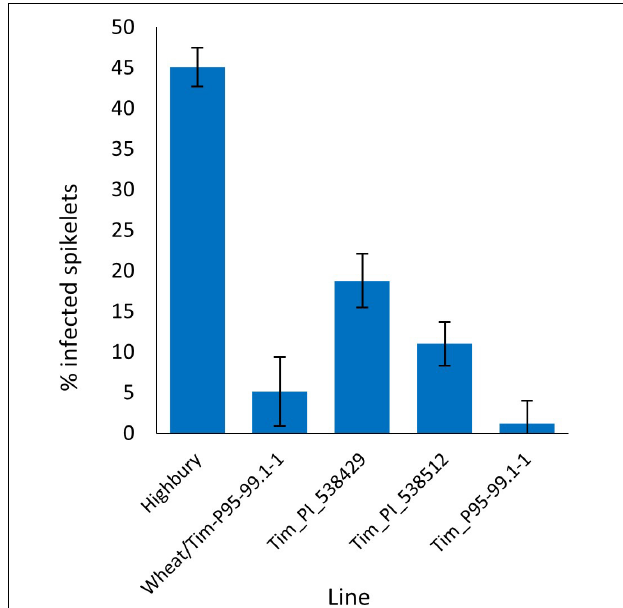
FIGURE 2 | Visual FHB disease score from 2016 trial of three T. timopheevii accessions, T. timopheevii × Highbury amphidiploid (wheat/Tim-P95-99.1-1) and wheat variety Highbury expressed as percentage of infected spikelets 14 days post spray inoculation with F. graminearum (1 × 10 5 conidia per ml).